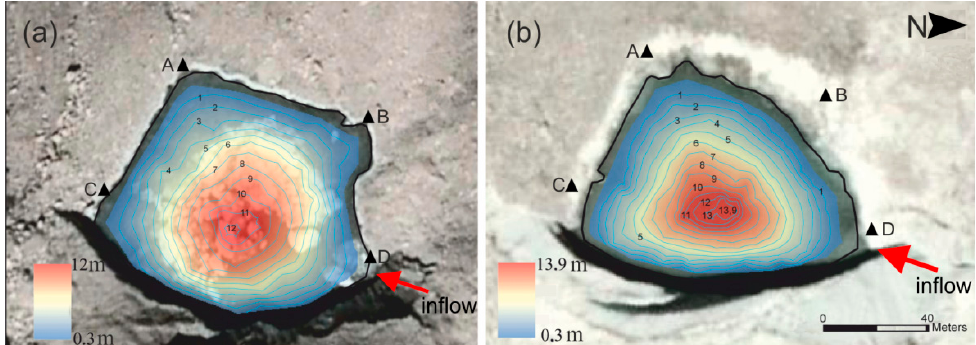
Figure 5. ( a ) Bathymetry map of the pro-glacial lake adjacent to the Uchitel Glacier in July 2012 ( b